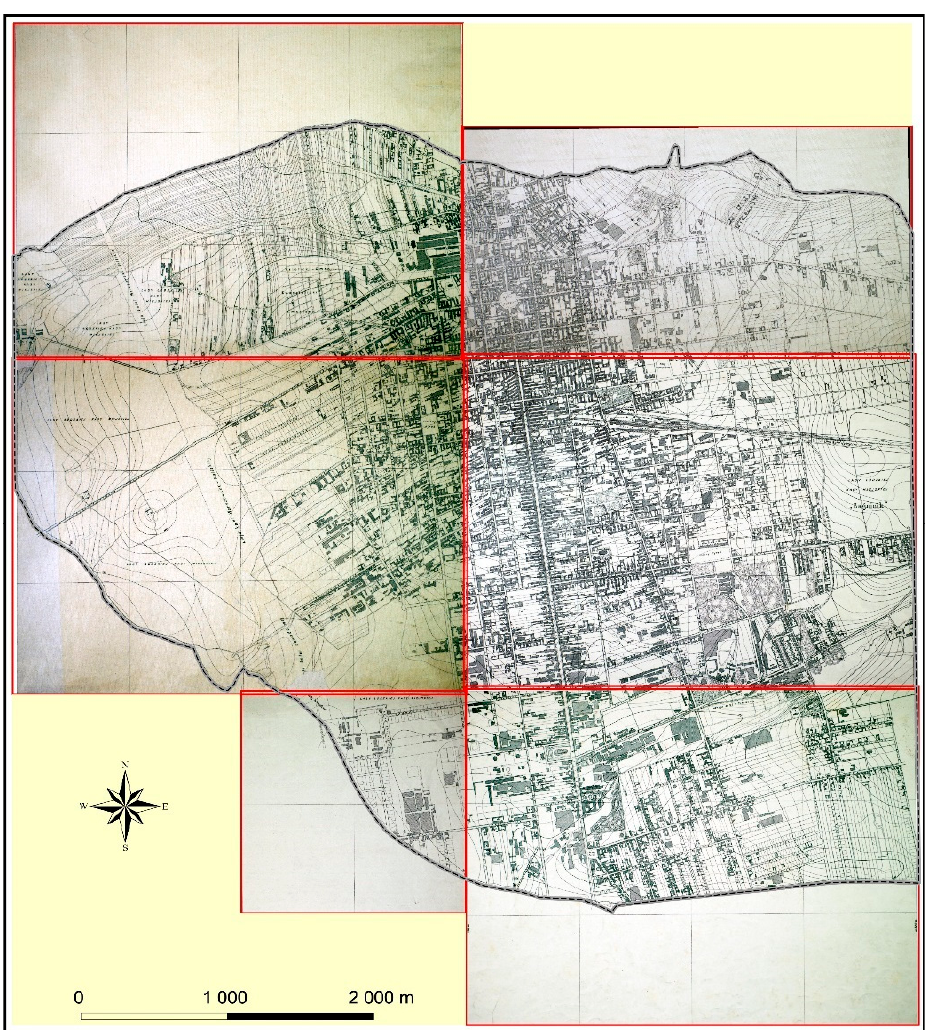
Figure 5. Compilation of Jasi ń ski’s 1917 map sheets. Source: State Archive in Ł ód ź .